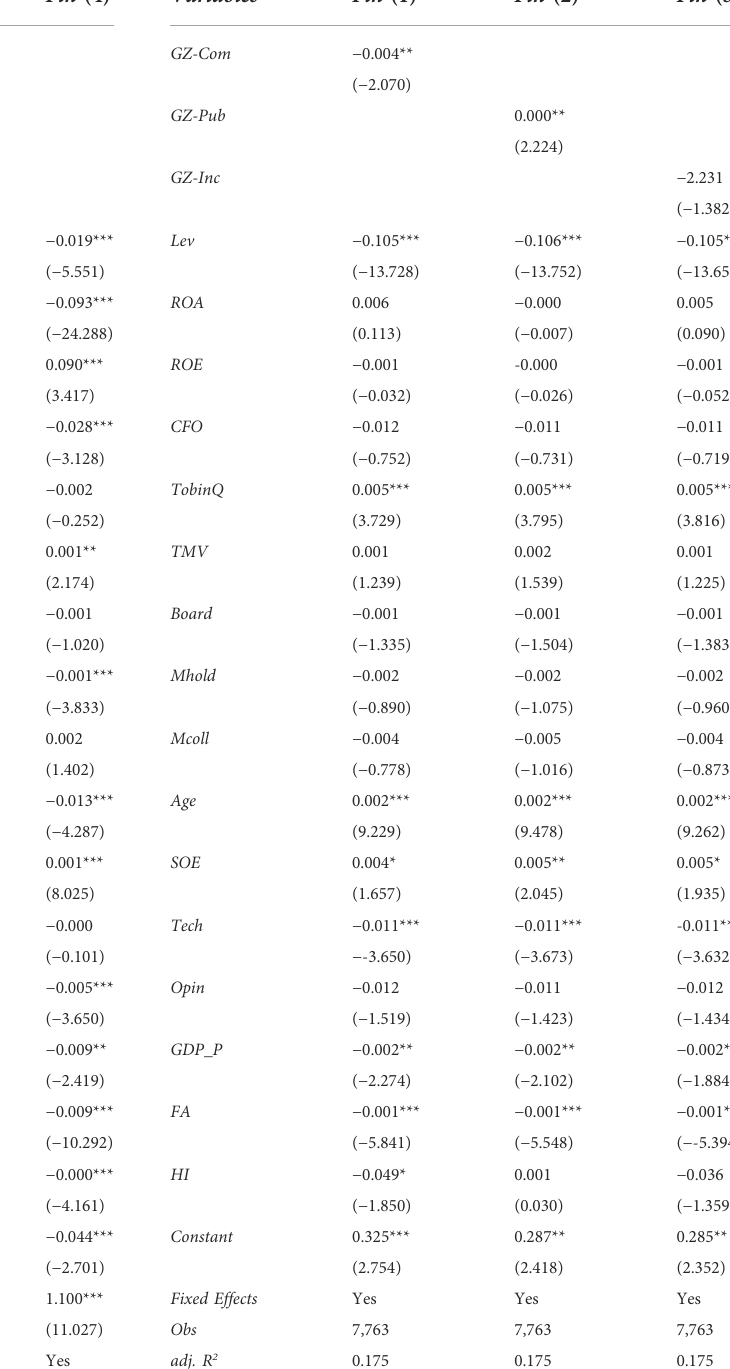
TABLE 6 Robustness test results of reduced sample of non- manufacturing enterprises.